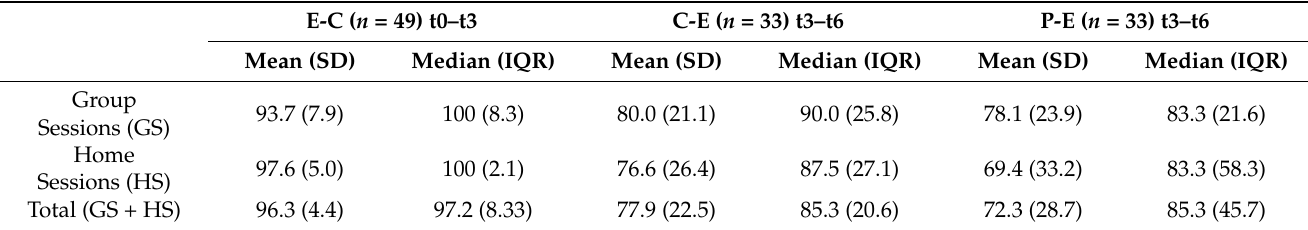
Table 5. Adherence to exercise training in % ( n =